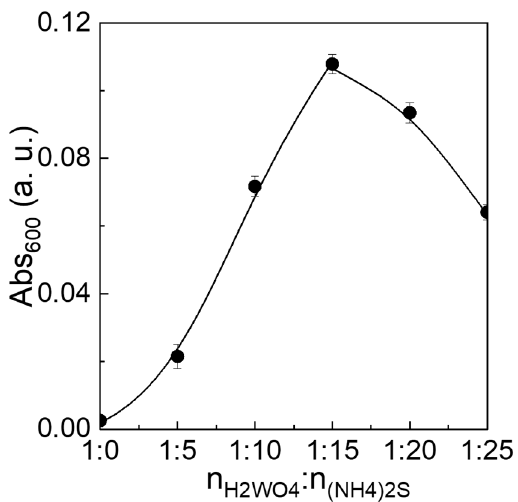
Figure 6. The absorbance values at 600 nm for the synthesized materials (WO 3 − 0, WO 3 − 5, WO 3 − 10, WO 3 − 15, WO 3 − 20, and WO 3 −